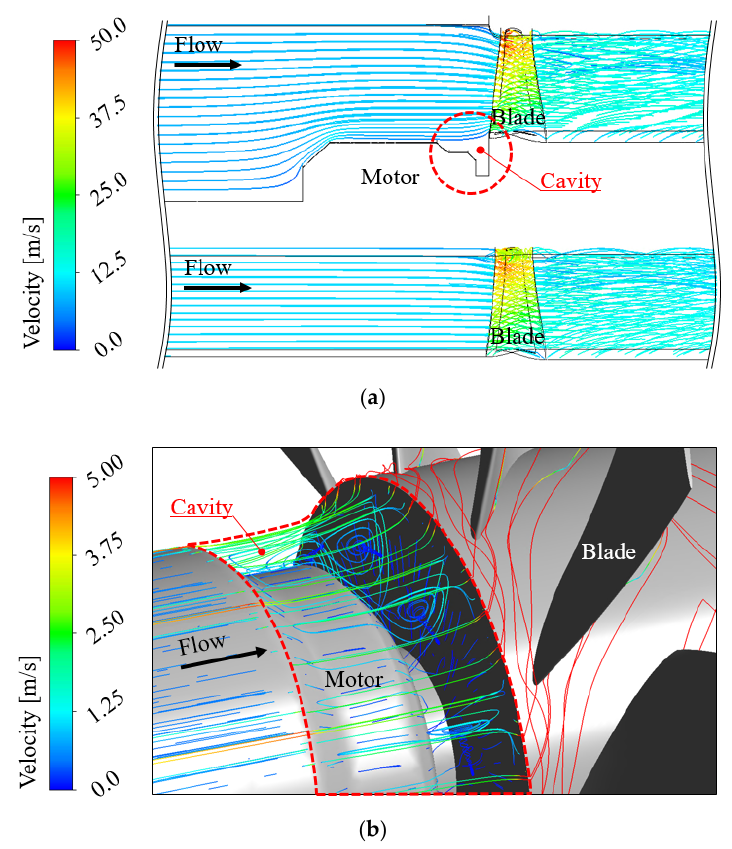
Figure 8. Internal flow pattern for the influence of the inlet motor (1.0 Φ d ). ( a ) 3D streamlines in a single-passage for inlet motor (upper) and straight flow passage (lower); ( b ) 3D streamlines near the dead region.